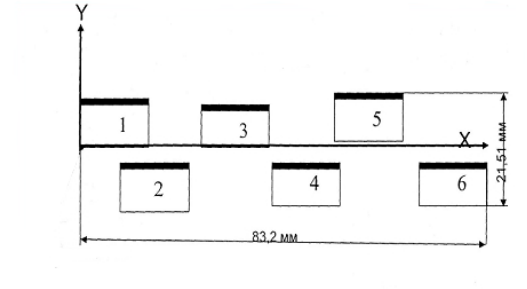
Figure 4. PSS micro matrixes placement in focal